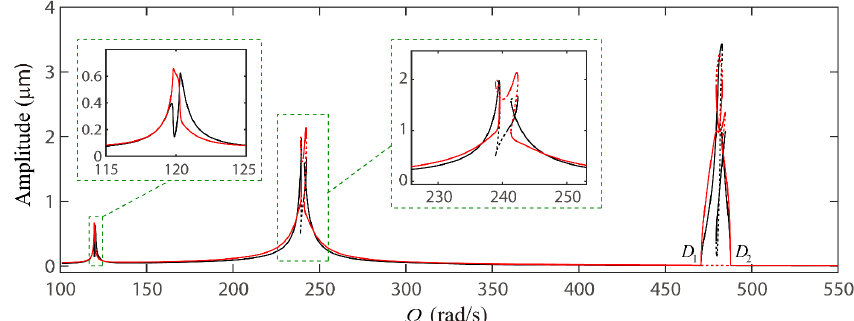
Figure 26. For δ 0 = − 1.1 μ m, stable (solid) and unstable (dashed) VC periodic peak-to-peak frequency–response curves in x (red line) and y (black line) directions.